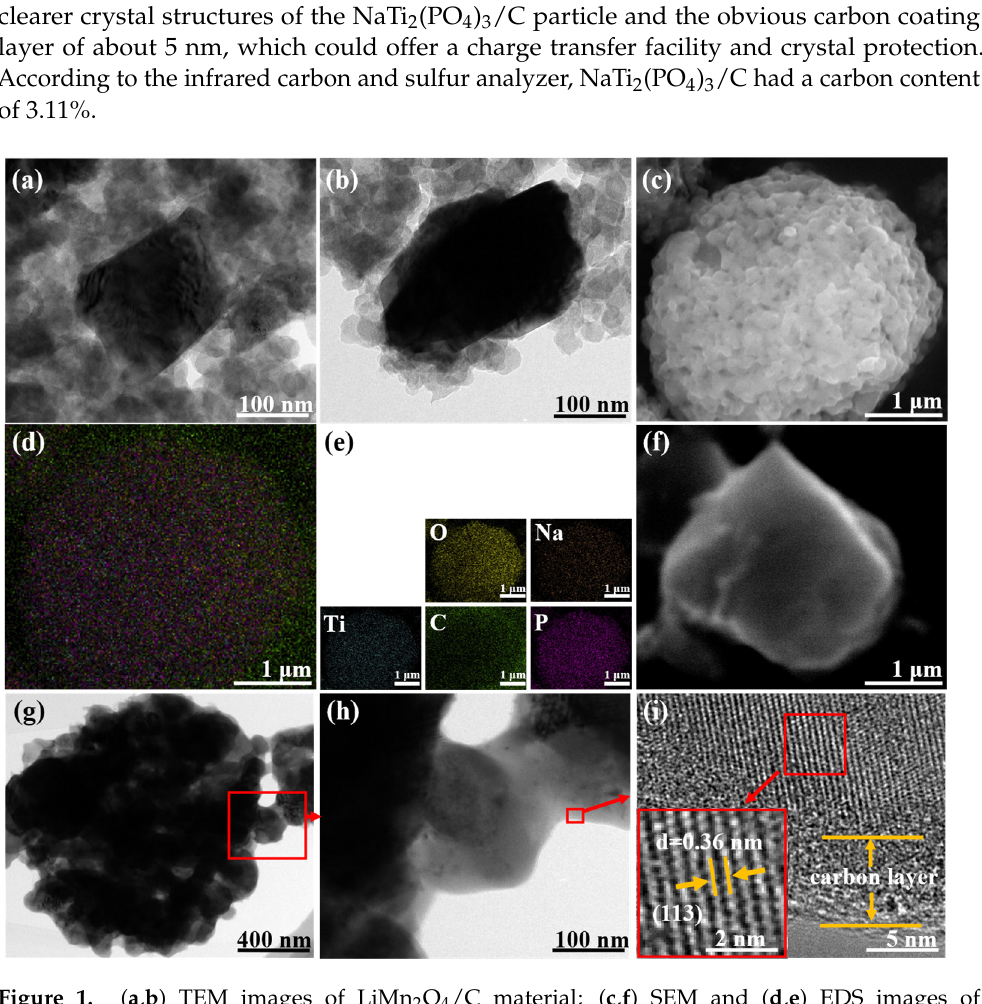
Figure 1. ( a , b ) TEM images of LiMn 2 O 4 /C material; ( c , f ) SEM and ( d , e ) EDS images of NaTi 2 (PO 4 ) 3 /C material; ( g – i ) TEM images of NaTi 2 (PO 4 ) 3 /C.